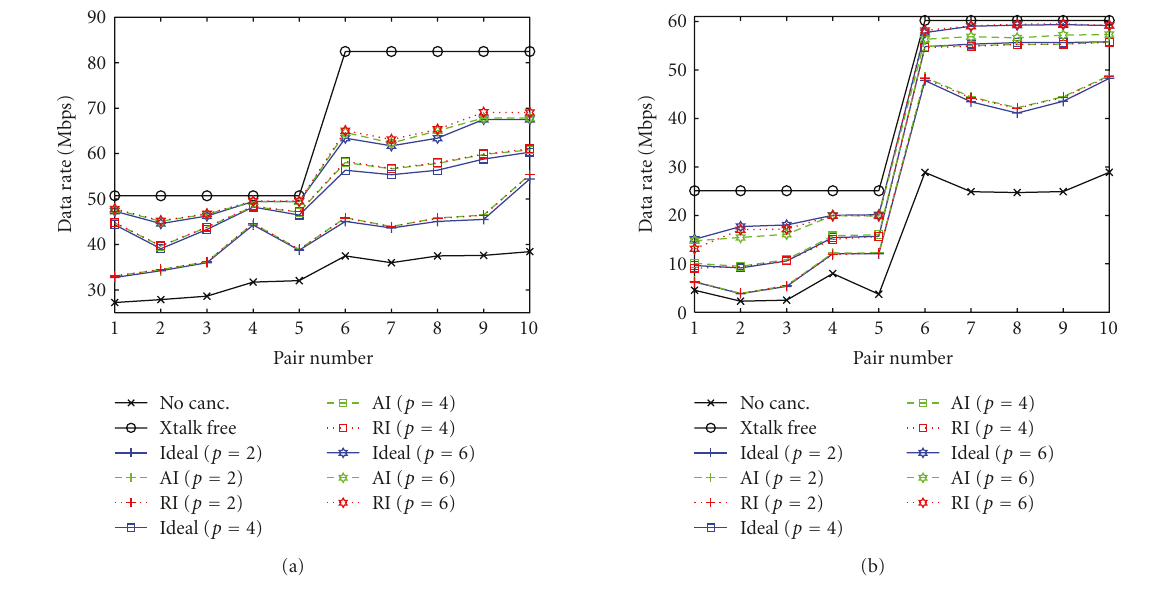
Figure 5: Data rates for LS scheme using the proposed AI and RI CMI methods compared to the ideal solution for near-far Scenario 2 (pairs 1 to 5: 600 m, pairs 6 to 10: 300m): (a) downstream and (b)